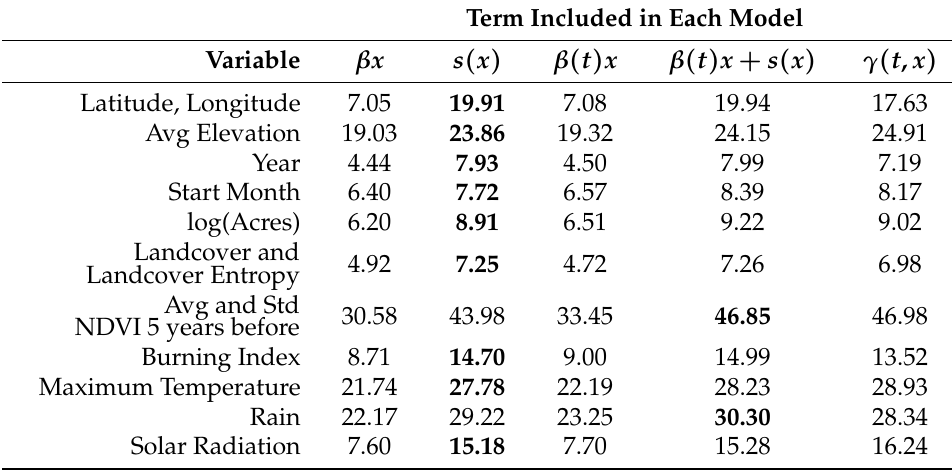
Table 2. Percentage of observed variability explained from 11 × 5 univariate or bivariate function- on-scalar regression models. For each row, the selected model is marked in bold. Term Included in Each